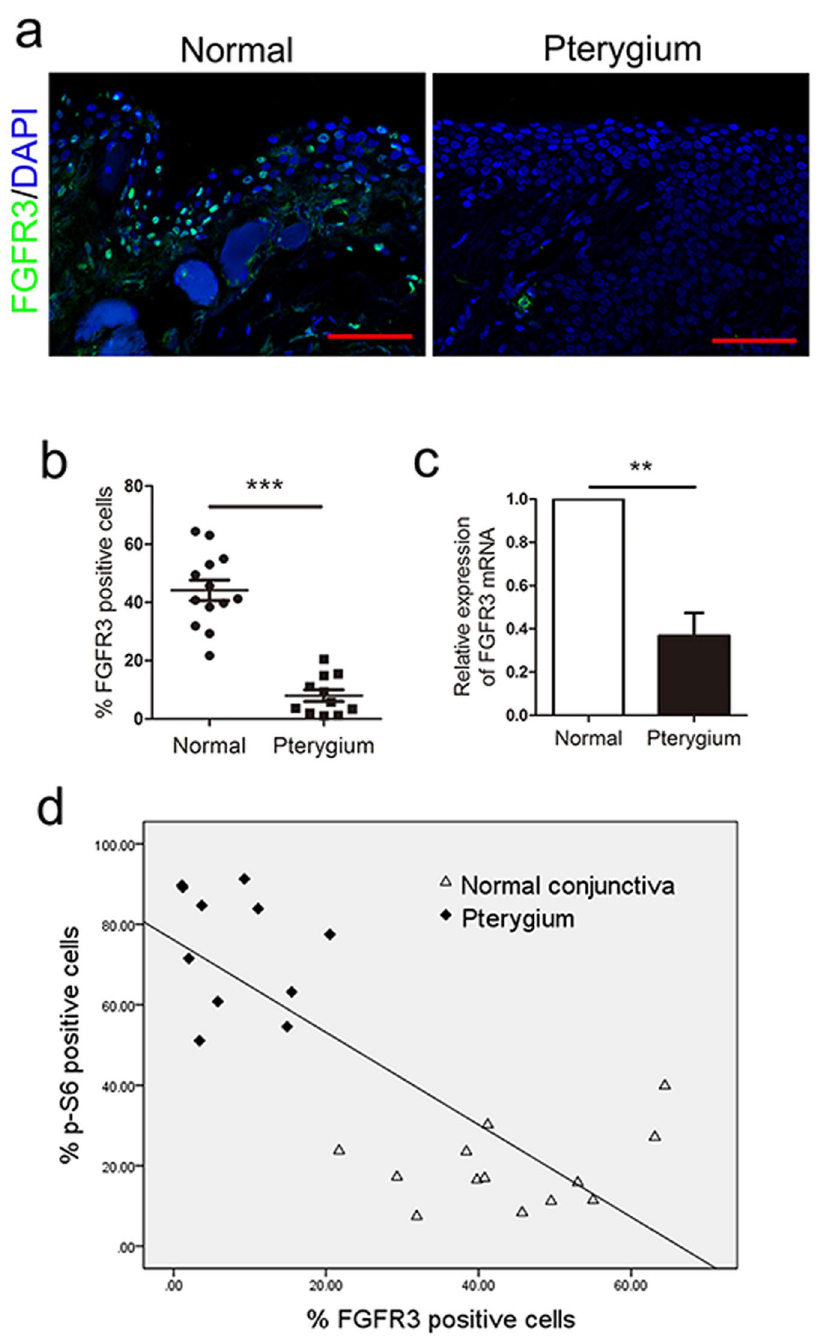
Figure 4. FGFR3 expression is decreased in pterygium. ( a and b ) Immunofluorescence staining and analysis of FGFR3 in pterygium compared with normal conjunctiva. ( c ) qPCR analysis of FGFR3 mRNA expression in pterygium and normal conjunctiva. ( d ) A statistically significant inverse correlation between p-S6 and FGFR3-positve cells (Pearson’s correlation: r = − 0.791, P < 0.01) was observed. Scale bar: 50 μ m. ** p < 0.01, *** p <